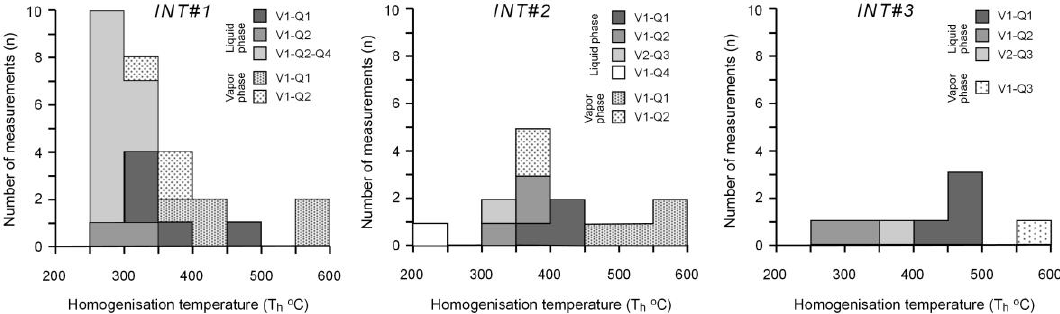
Figure 13. The distribution of the homogenization temperatures (T h , °C) of the fluid inclusions in different generations of quartz from the different intrusions.